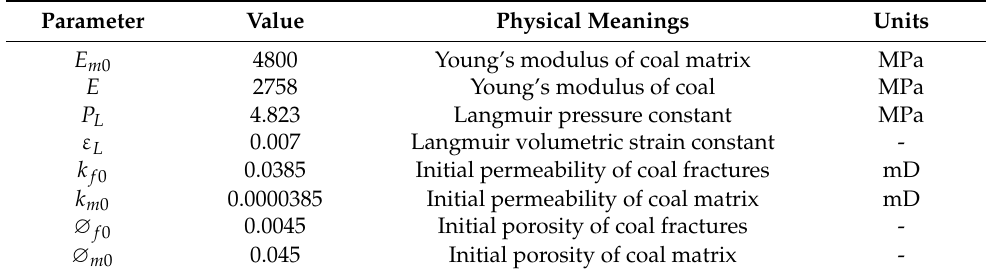
Figure 7. Experimental set-up and results for Anderson coal. Table 3. Key parameters for Anderson coal in the numerical simulations [40].